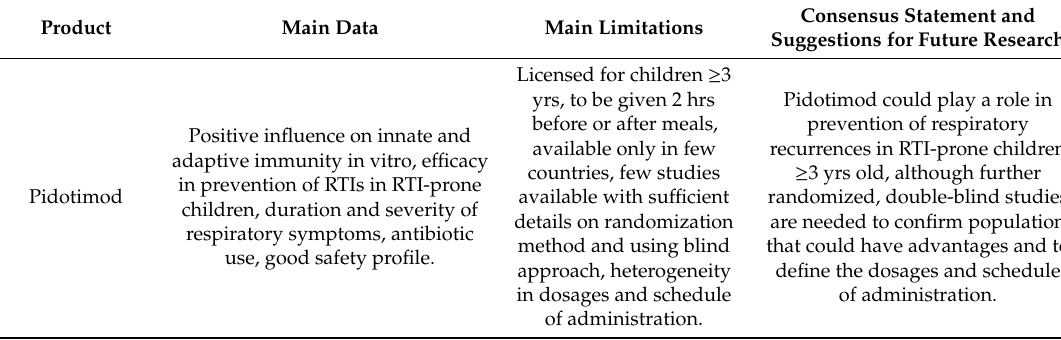
Table 1. Consensus statements on products used for prevention of respiratory tract infections (RTIs) in RTI-prone